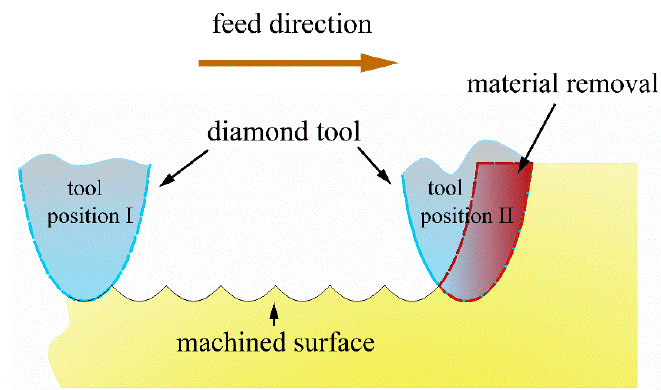
Figure 1. The cross-sectional profile generated in the ultra-precision diamond turning process under the ideal condition.